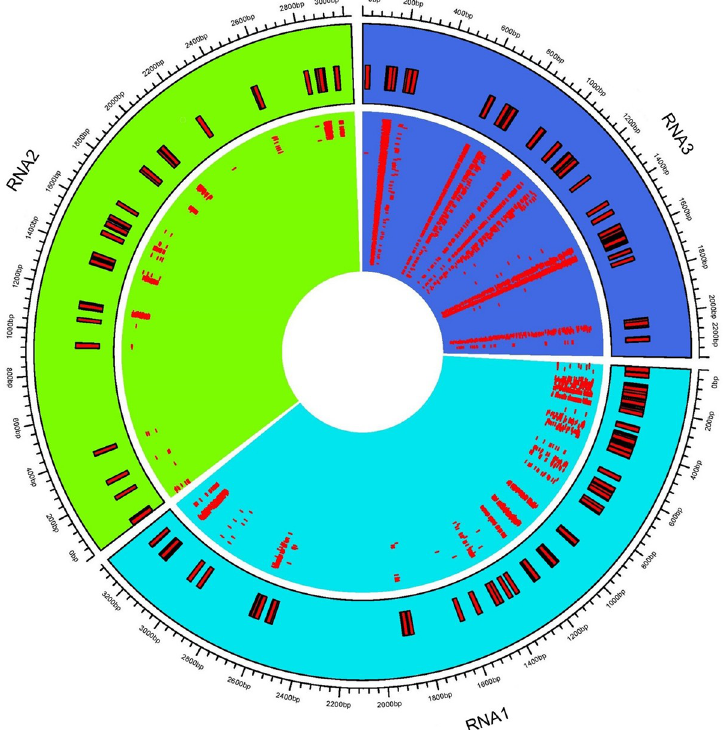
Fig 5. Distribution of virus-derived siRNA (vsiRNA) across cucumber mosaic virus (CMV) RNAs. The consensus vsiRNA distribution across three CMV RNA1, RNA2, and RNA3. The inner rectangles show reads mapped to respective viral RNA. Outer rectangles relate genome coordinates of consensus reads mapped to CMV